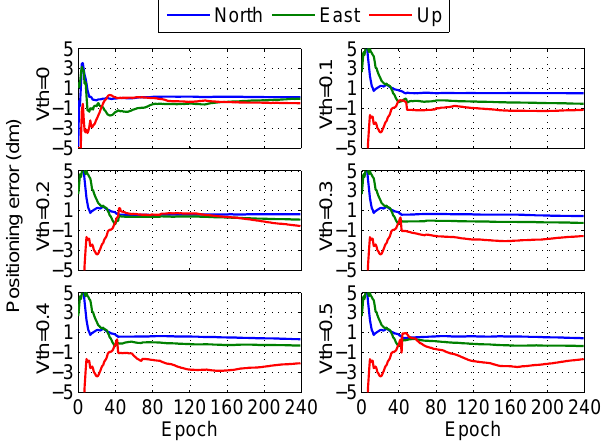
Figure 6. Positioning error of fixed solution in different thresholds at station CNMR in the post-processing